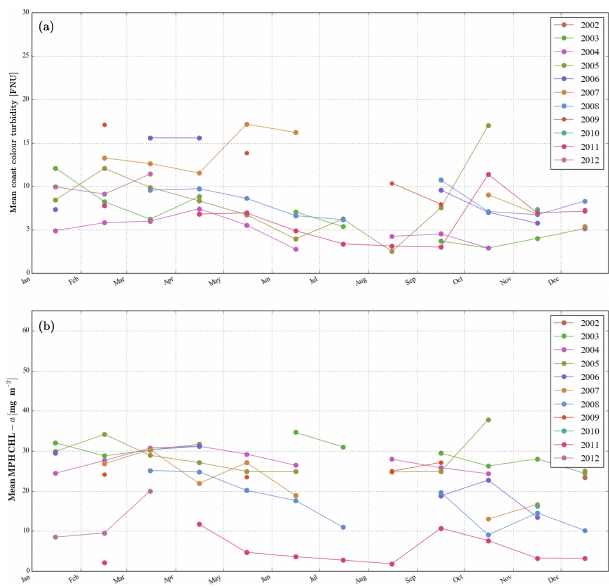
Figure 14. Time series of spatially averaged turbidity (a) and chl (b) in Lake Nicaragua, with data gaps especially during the rainy season